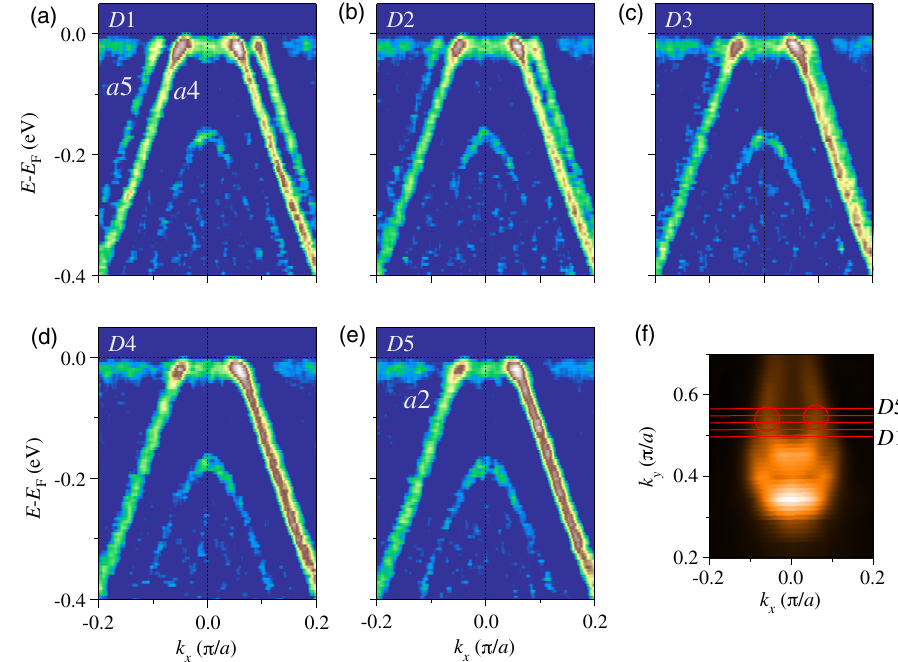
FIG. 5. (a) – (e) Curvature intensity plots of ARPES data along D 1 - D 5 , respectively. (f) ARPES intensity plot at E F around the Weyl-node projection W1. Red lines represent the momentum locations of cuts D 1 - D 5 sliding through